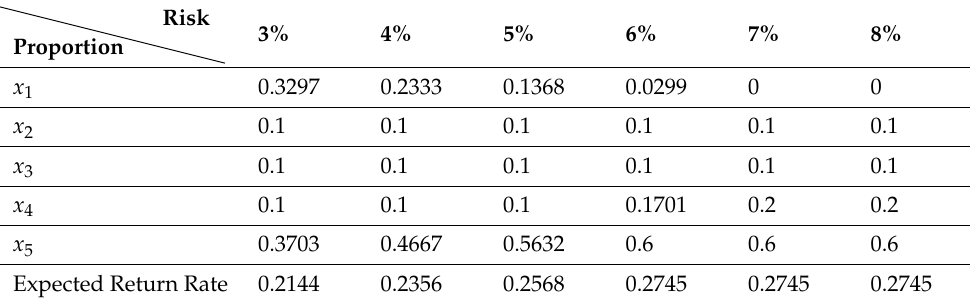
Table 1. An efficient portfolio with a guaranteed return rate (cid:101) p 1 .